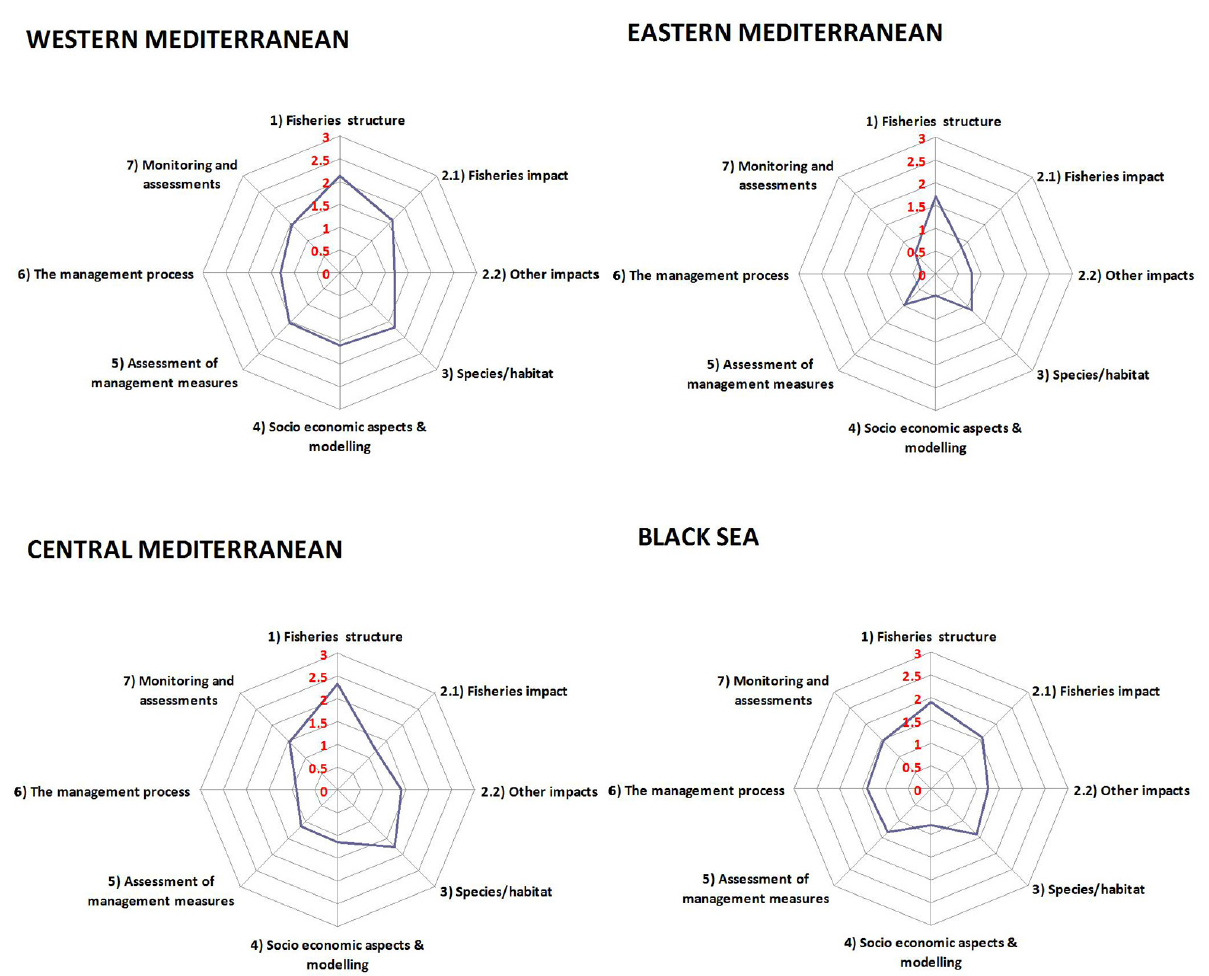
Fig. 3. – Radar graphs showing the overall overview of the expert evaluation on the capacity to address the EAF issues according to main basins. Scores ranges from 0 to 3 (from null to high capacity to address each issue related to the